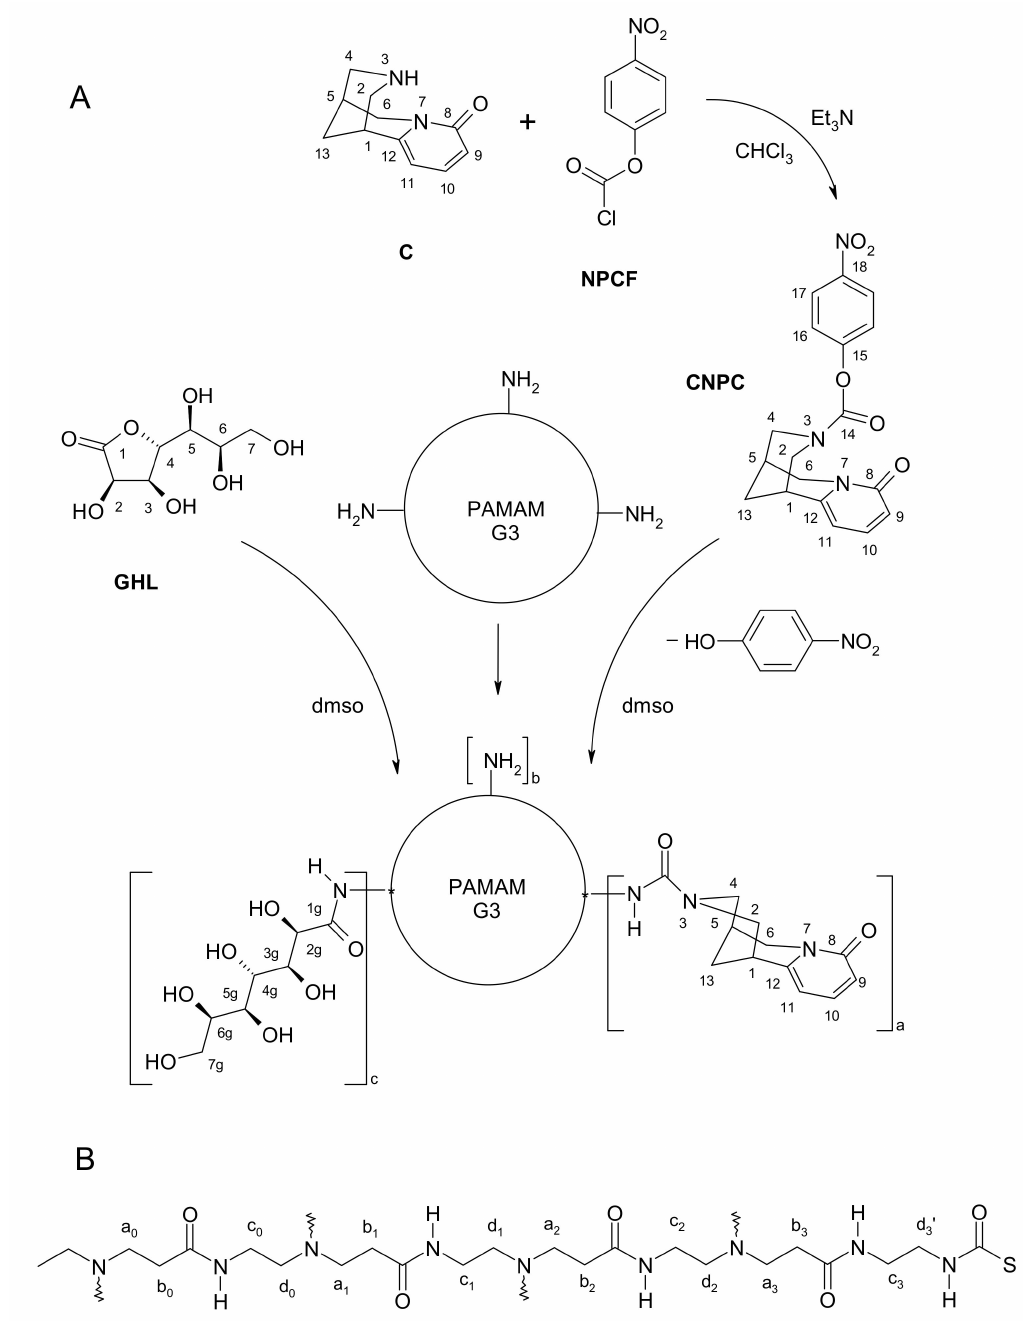
Scheme 1. Synthetic path to PAMAM G3–ytisine–glucoheptoamide ( G3 Cgh ) conjugates ( A ). Atom numberings for cytisine ( C ), p -nitrophenylchloroformate ( NPCF ), and d -glucoheptono-1,4-lactone ( GHL ) are given in schematic formula of G3 Cgh dendrimer and substrates in trace ( A ). Selected chain of dendrimer is shown in trace ( B ) with atom numbering. Branches at ternary nitrogen atoms are indicated by waived lines. S represents gh or C substituents. The following conjugates were synthesized: G3 5gh (a = 0; b = 5; c = 27), G3 10gh (a = 0; b = 10; c = 22), G3 16gh (a = 0; b = 16; c = 16), G3 18gh (a = 0; b = 18; c = 14), G3 2C16gh (a = 2; b = 16; c = 14), G3 2C23gh (a = 2; b = 23; c = 7), G3 2C26gh (a = 2; b = 26; c = 4), G3 3C14gh (a = 3; b = 14; c = 15), and G3 9C11gh (a = 9; b = 11; c =